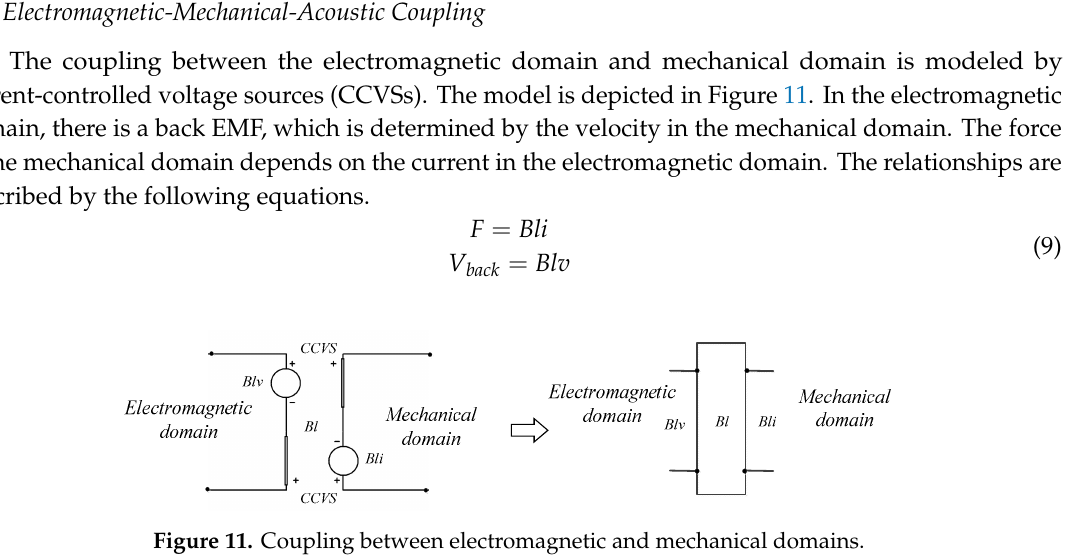
Figure 11. Coupling between electromagnetic and mechanical domains.